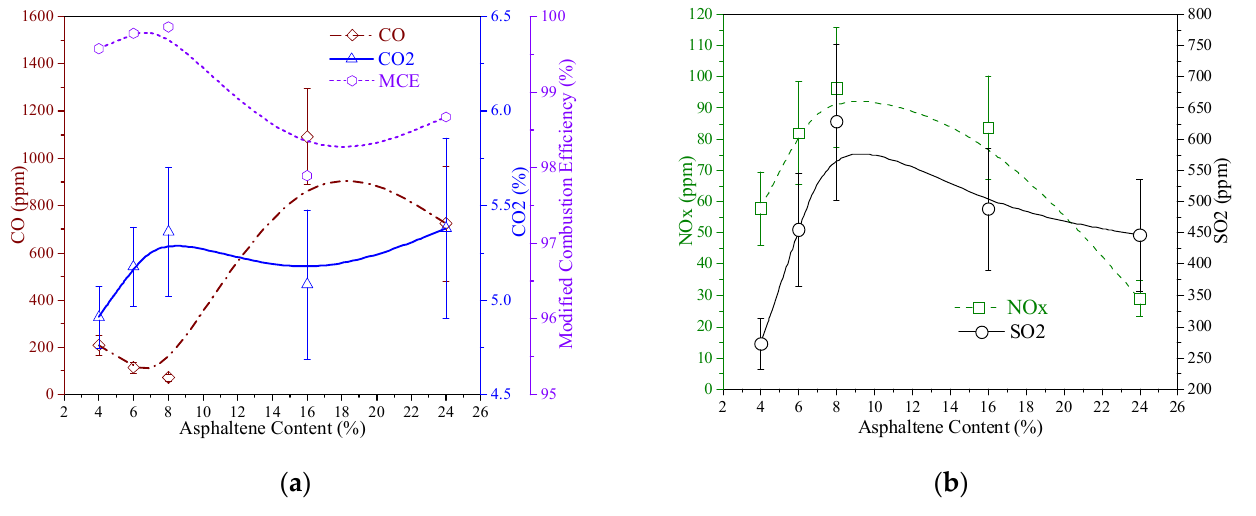
Figure 7. Gaseous emissions of fuel combustion with different asphaltene contents ( a ) CO and CO 2 . ( b ) NO x and SO 2 .